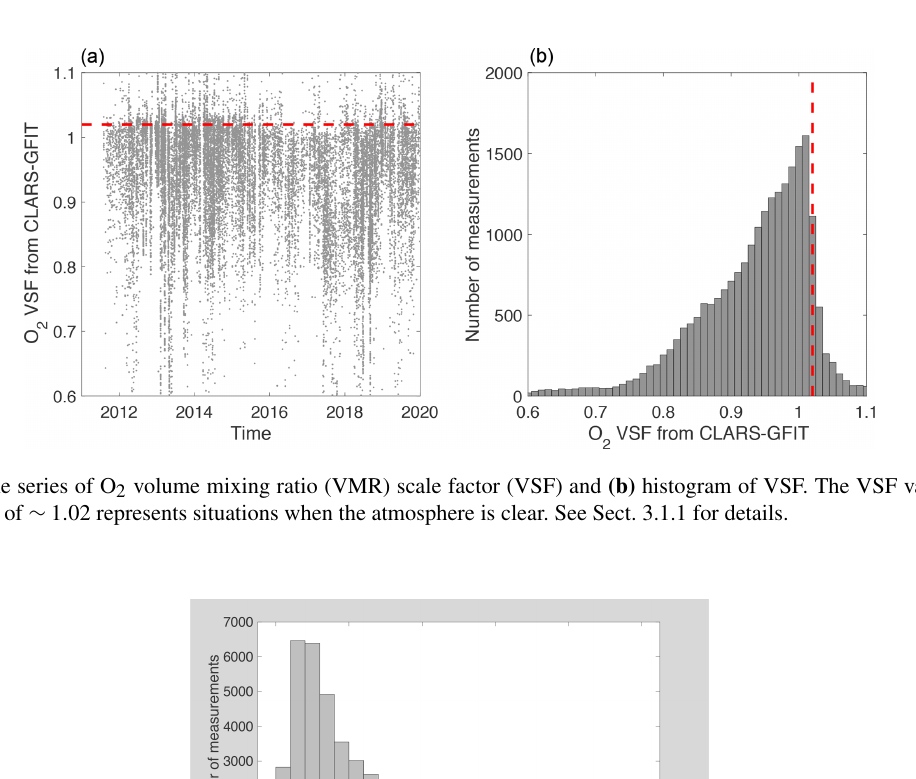
Atmos. Meas. Tech., 14, 6483–6507,